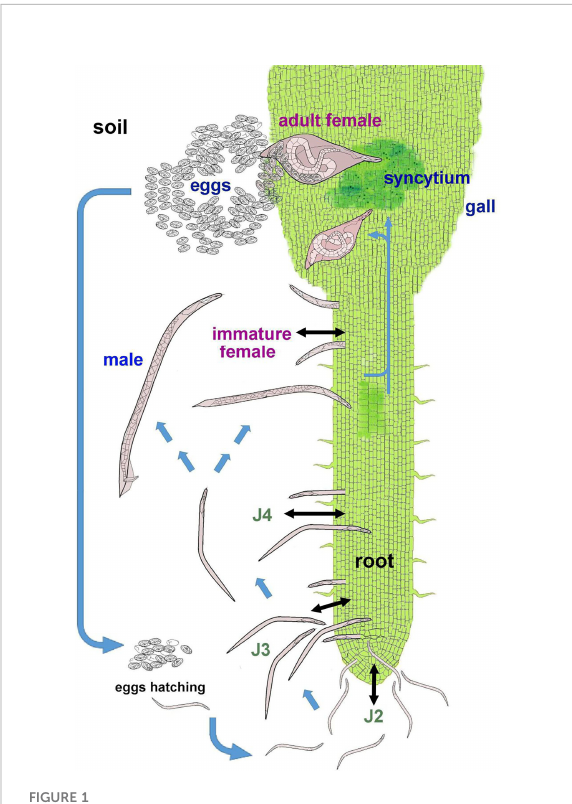
FIGURE 1 Life cycle of Nacobbus spp. Blue arrows indicate the development of the different stages through the life cycle; black arrows represent the movement of the infective stages, both in soil and in roots. In soil, the J2 hatches from the egg and then molts to J3 and J4. These stages enter the root, migrate causing necrosis and can also leave the host tissues. The J4 molts again to a male or immature female. The female invades the root, migrates in proximity of the central cylinder and causes histological alterations that induce the feeding site (syncytium) and the formation of the gall. The female body swells as she feeds. Once fertilized by the male, the female produces an egg mass, which is laid on the gall in contact with soil